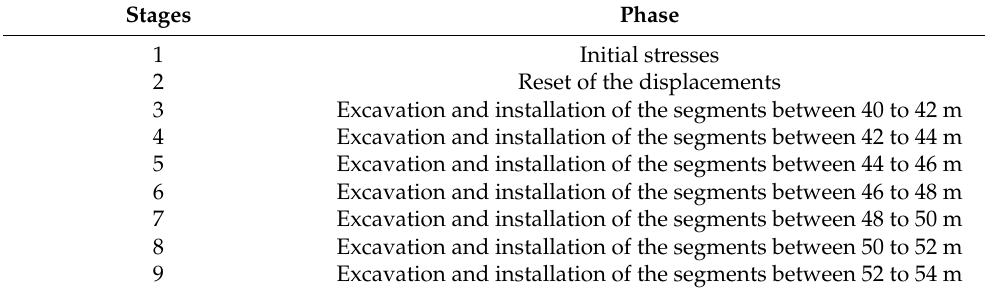
Table 6. Deformation